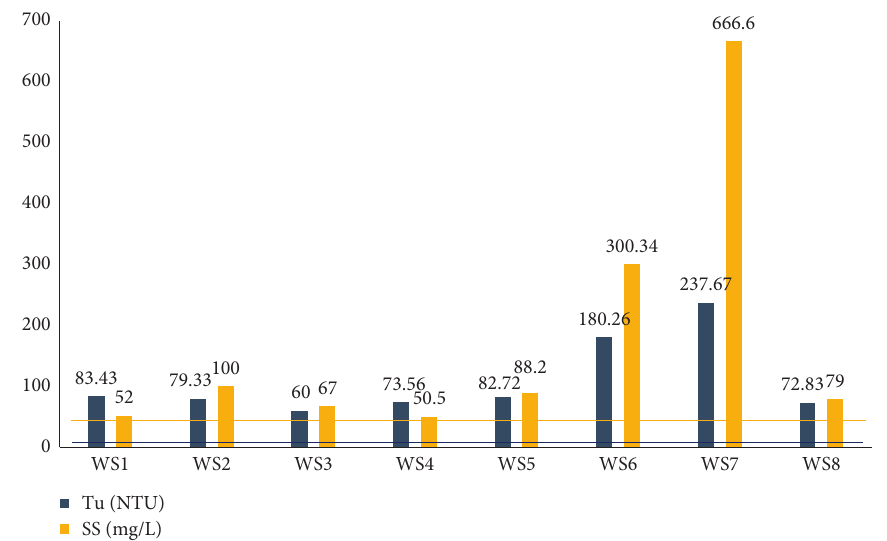
Figure 4: Physical characteristics (Tu and SS) of the sampling